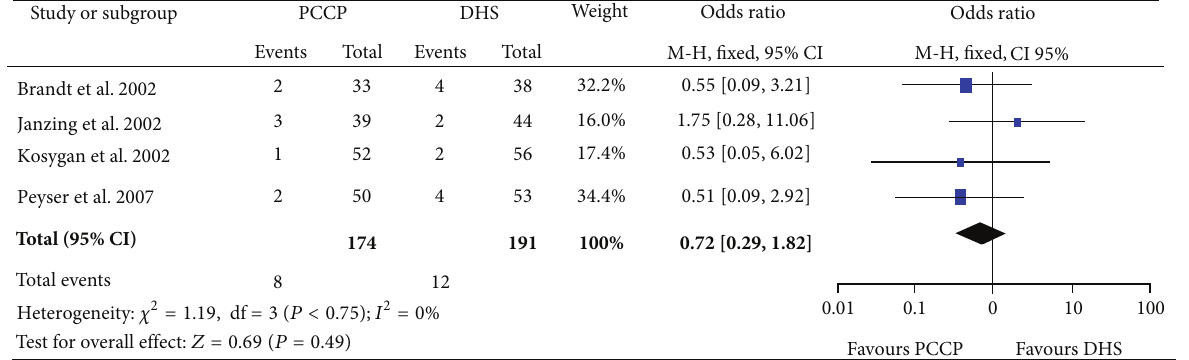
Figure 7: Comparison of implant-related complications between PCCP and DHS.